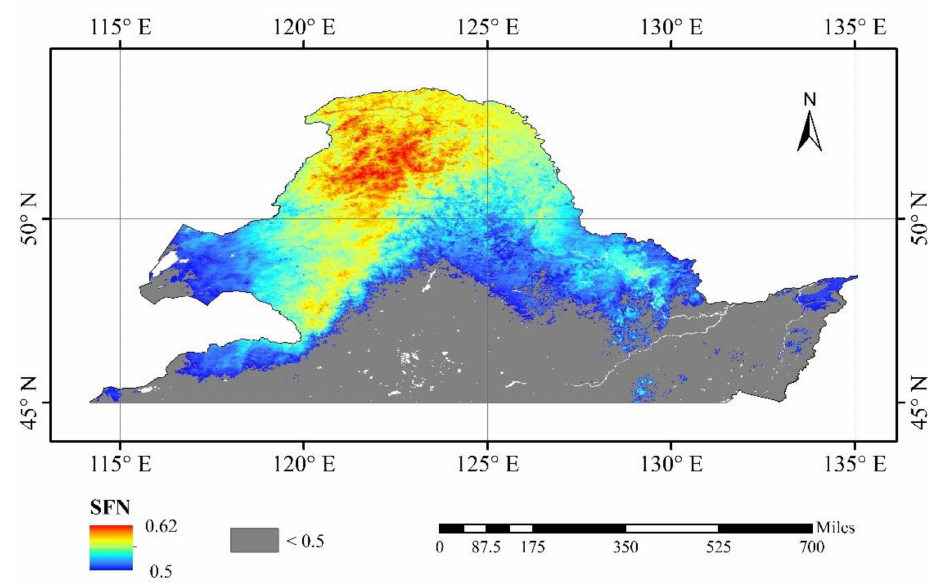
Figure 3. Spatial distribution of SFN values in Northeast China from 2001 to